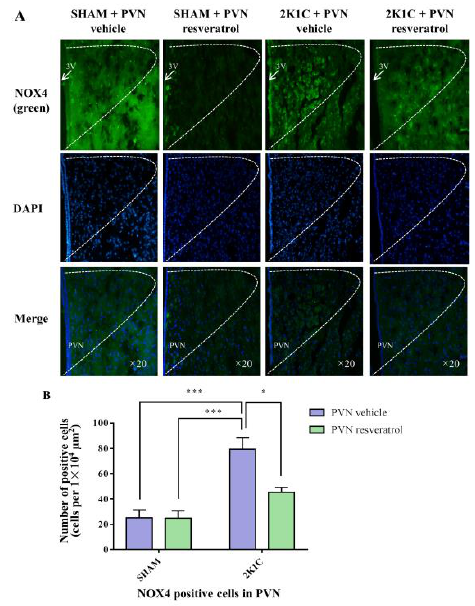
Figure 6. The effects of PVN resveratrol on NOX4 expression. ( A ) Immunofluorescence staining of NOX4 (green fluorescence, ×20) and ( B ) statistics of NOX4 positive cells. 3V: third ventricle. Values are the mean ± SEM. * p < 0.05, *** p < 0.001, n = 4.